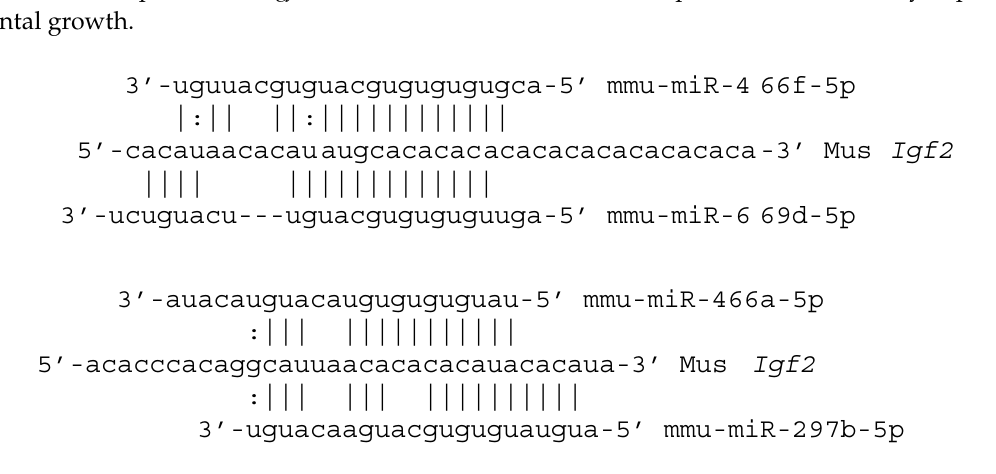
Figure 2. A sample of C2MC miRNAs-5p binding to the AC-rich sequence of mouse Igf2 3 ′ UTR.